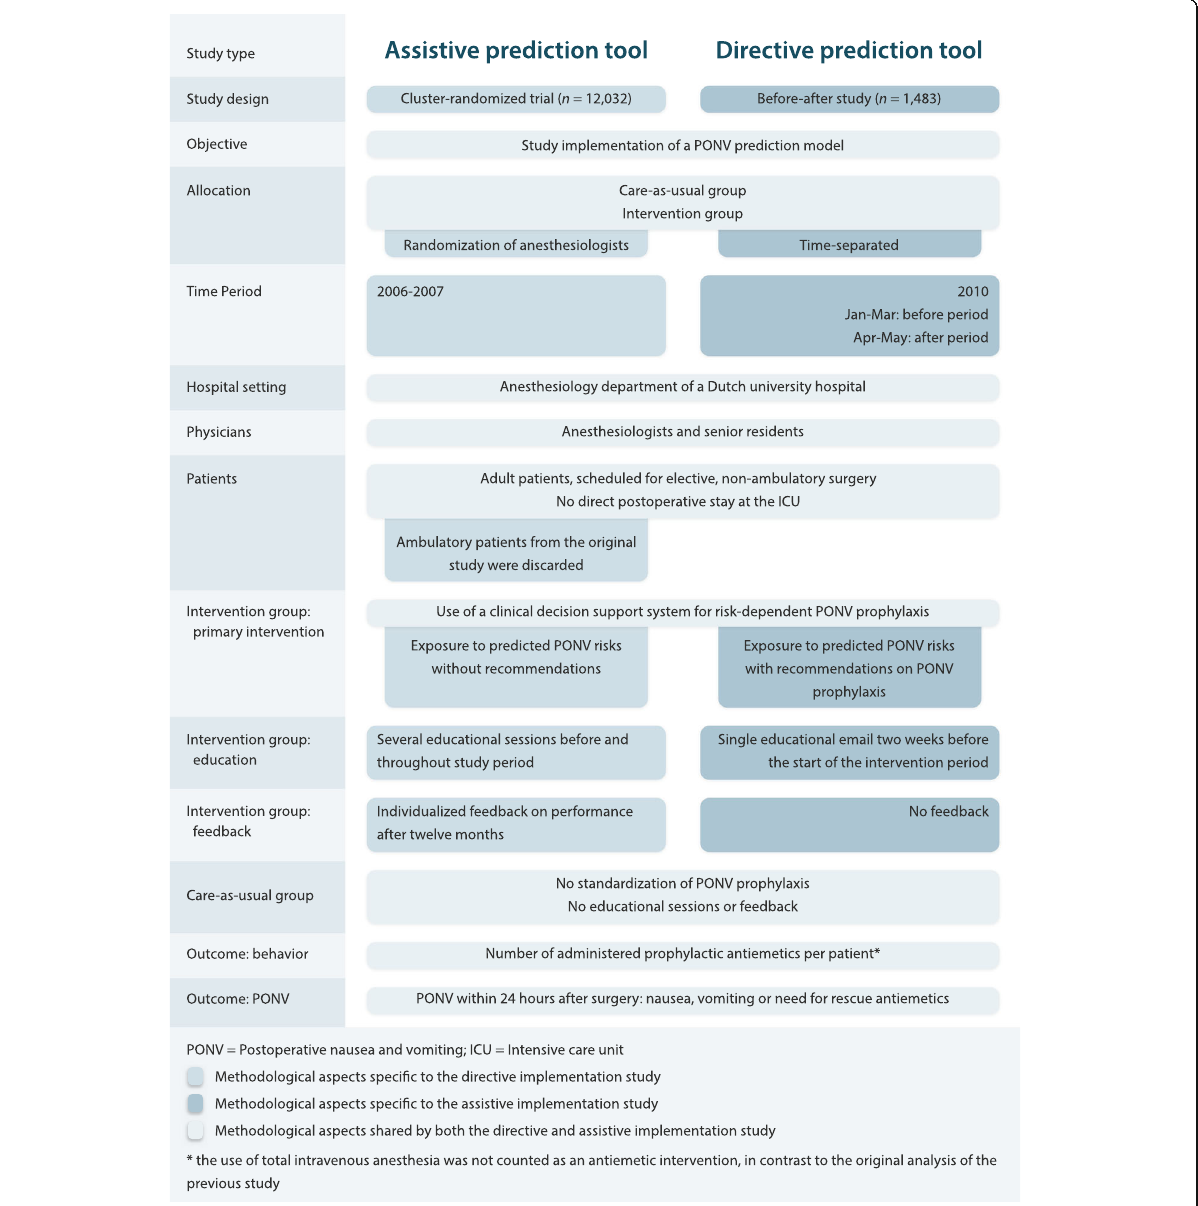
Fig. 1 Methodological similarities and differences between our cluster-randomized trial with an assistive prediction tool (first study) and